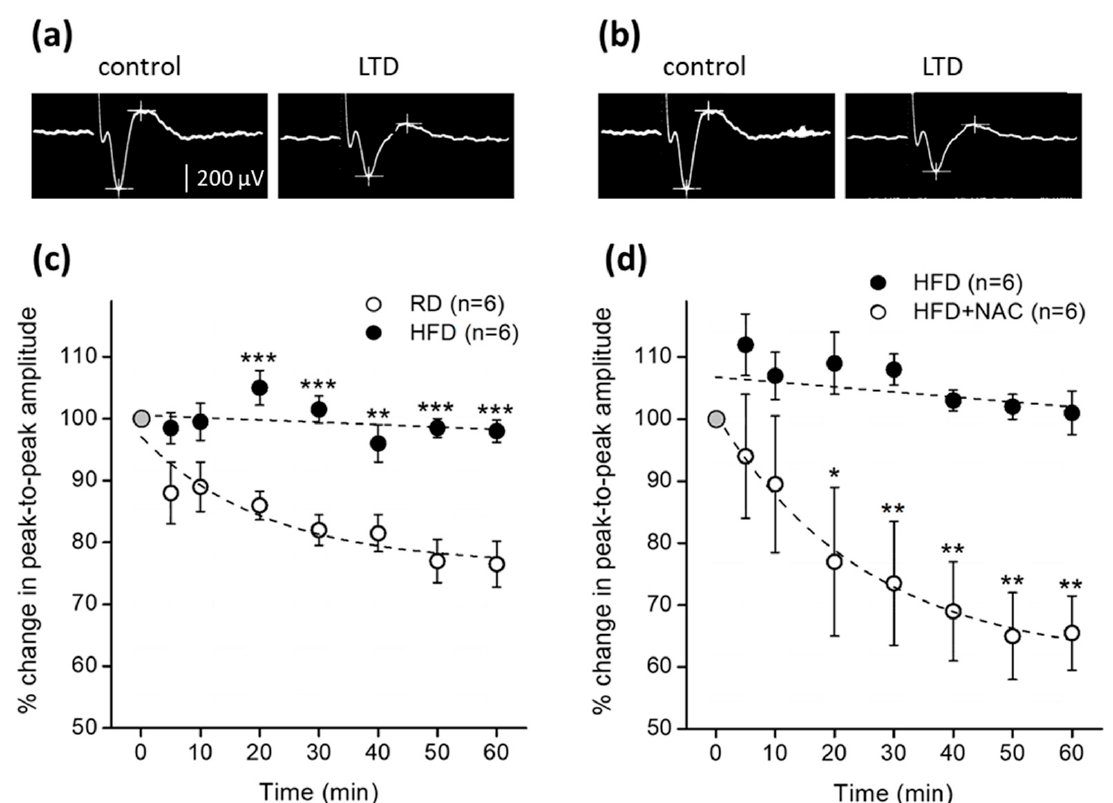
Figure 2. Characterization of in vivo LTD in the NAc core of young mice fed either RD or HFD for 2 weeks and then subjected to an abstinence period for 5 days. Field potentials were evoked in the NAc core from the ipsilateral mPFC and the effect of an LTD-evoking protocol assessed. ( a ) Repre- sentative example of the average of 12 successive mPFC-NAc core evoked field responses in a mouse fed RD, before (control) and after (LTD) application of the LTD- evoking protocol (see Materials and Methods); peak-to-peak amplitude is indicated by cursors (see calibration bar). The LTD-evoking protocol failed to evoke LTD in HFD-primed mice (not shown). ( b ) Similar to ( a ), but this time field responses were evoked in NAc of a HFD-primed pre-treated with 100 mg/kg i.p. N-acetylcysteine 2.5 h before the application of the LTD protocol. Note that N-acetylcysteine prevented the LTD from failing. ( c ) Time-course of % change in peak-to-peak amplitude of field potential evoked in the NAc core by electrical stimulation of the ipsilateral mPFC, after application of the low-frequency stimu- lation protocol at time zero min. Two-way repeated measures ANOVA revealed a treatment effect (RD vs. HFD, n = 6 mice per group, F 1, 10 = 95.77). Asterisks indicate statistically significant intergroup differences (** p < 0.01, *** p < 0.001, Bonferroni multiple comparisons post-hoc test), as the LTD nor- mally evoked by the low-frequency stimulation protocol in the NAc core of control mice fed RD (empty circles), was suppressed in the NAC core of HFD-primed mice as revealed by unchanged peak-to-peak amplitude of NAc core responses (filled circles). ( d ) 100 mg/kg i.p. N-acetylcysteine, administered 2.5 h before the application of the low-frequency stimulation protocol, prevented the LTD suppression in HDF-primed mice. Two-way repeated measures ANOVA revealed a treatment effect (HFD vs. HFD+NAC, n = 6 mice per group, F 1, 10 = 56.22). Asterisks indicate statistically signif- icant intergroup differences (* p < 0.05, ** p < 0.01, Bonferroni multiple comparisons post-hoc test), as N-acetylcysteine prevented LTD suppression in HFD-primed mice.